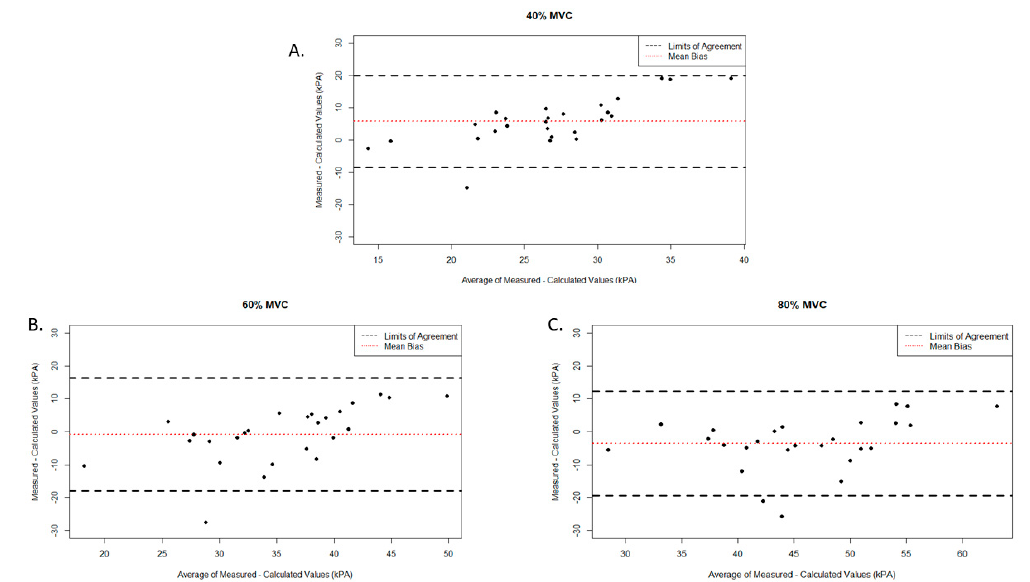
Figure 2. Bland–Altman plots of tongue intensity estimates. MVC = maximal voluntary isometric contraction. ( A ). 40% MVC; ( B ). 60% MVC; ( C ). 80% MVC.